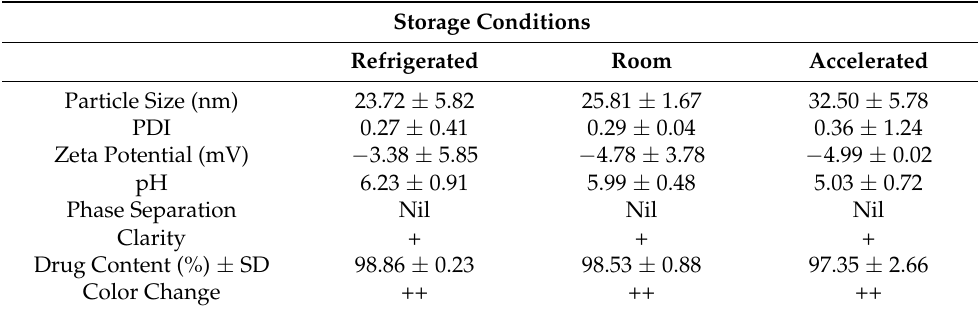
Table 9. Storage stability of methotrexate nanogel formulations at refrigerated, room, and accelerated temperatures for 3 months. Storage Conditions Refrigerated